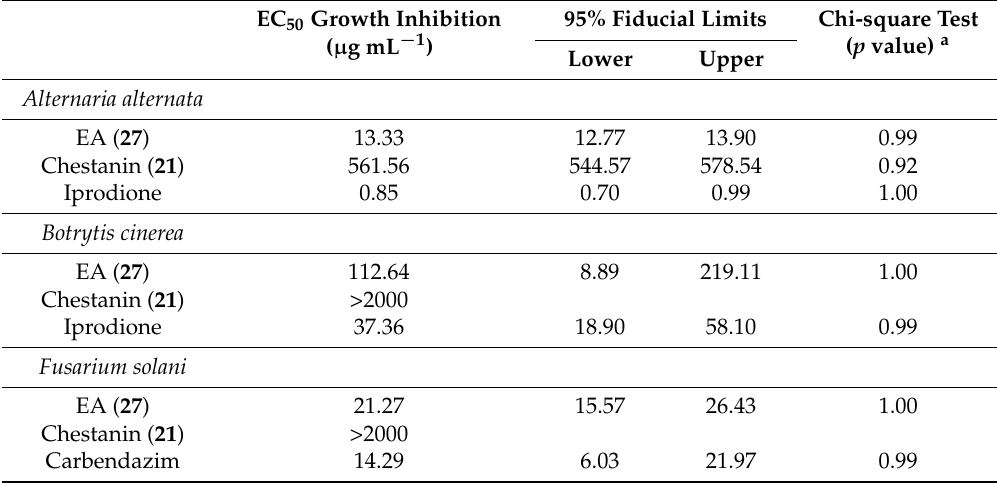
Table 5. EC 50 of pure compounds compared to synthetic fungicides (iprodione, and carbendazim) inhibiting Alternaria alternata , Botrytis cinerea and Fusarium solani spore germination. EC 50 Growth